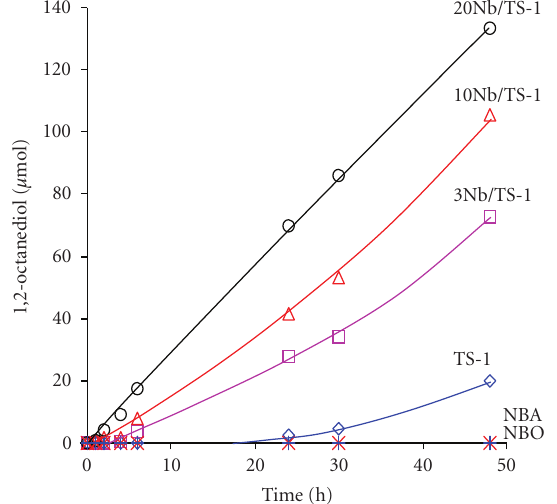
Figure 11: The yield of 1,2-octanediol from 1-octene epoxidation of using H 2 O 2 at 70 ◦ C catalyzed by NBA, NBO, TS-1, and X Nb/